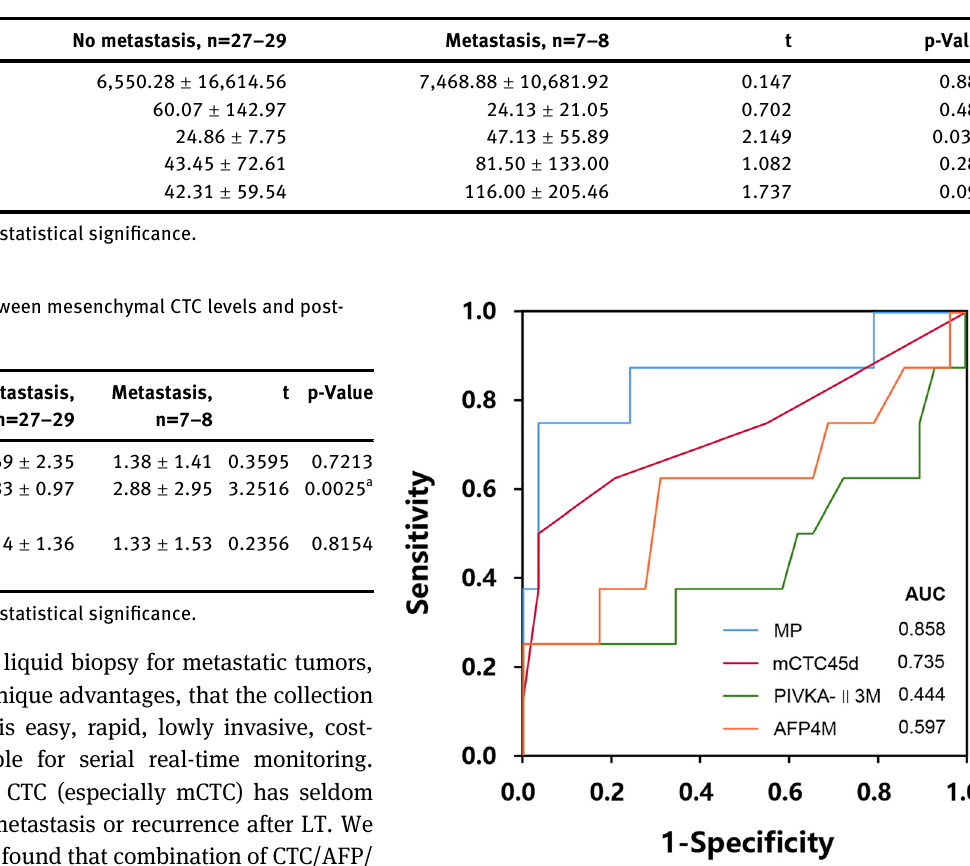
Figure 1: Receiver operating characteristic (ROC) curve for efficacy analysis of risk factors in post-LT metastasis in two